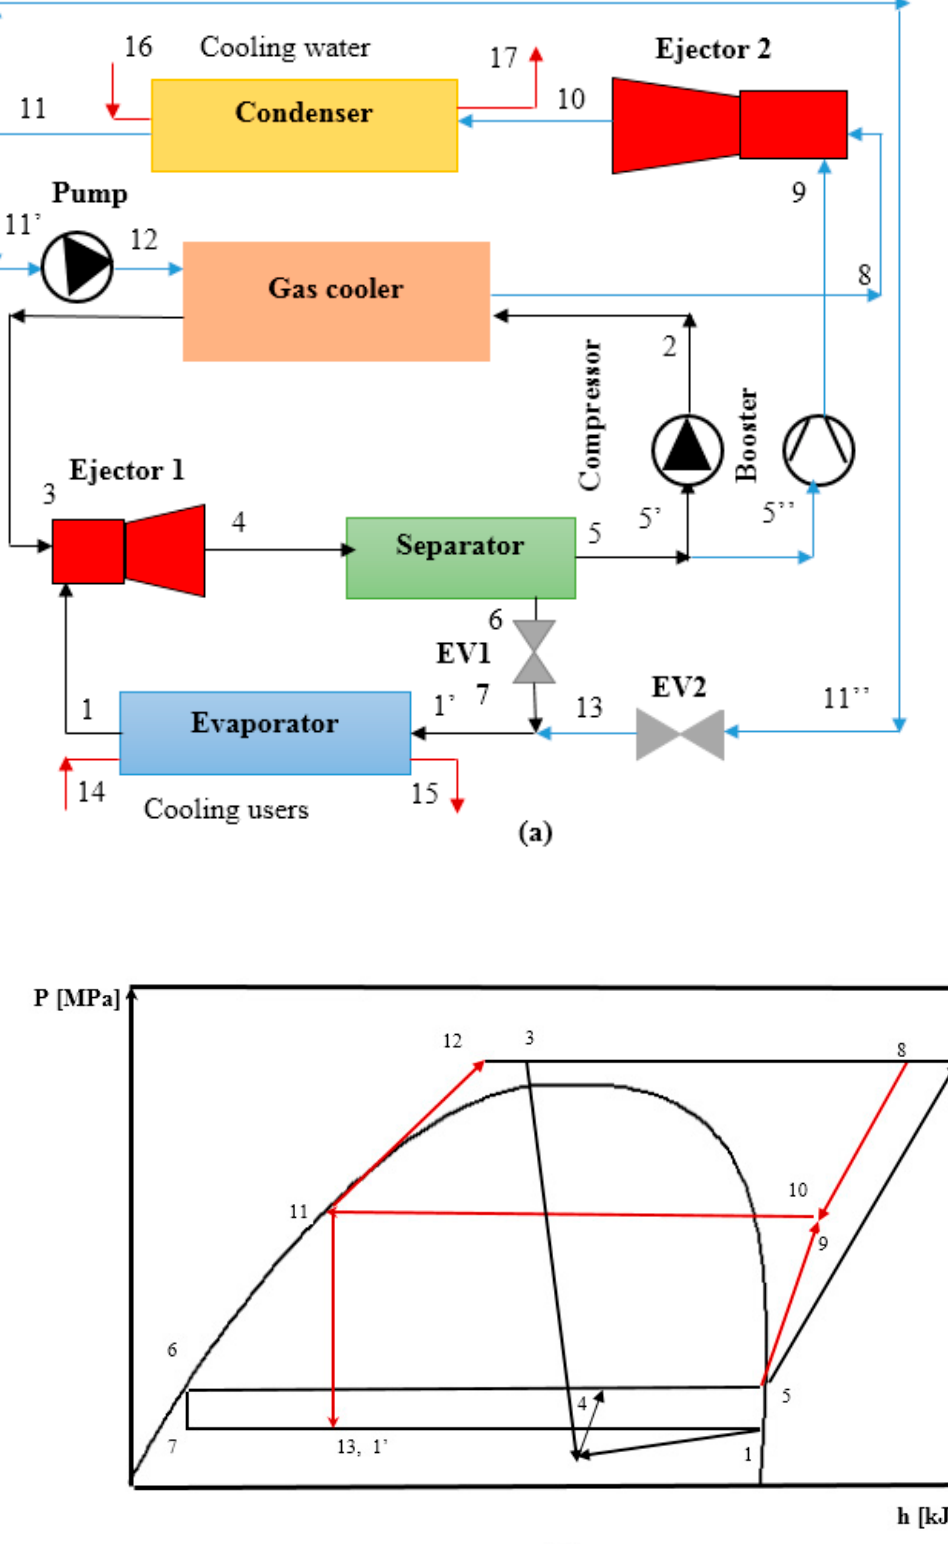
Figure 2. ( a ) Novel transcritical refrigeration cycle (NTRC) schematic diagram, ( b ) NTRC P-h diagram.